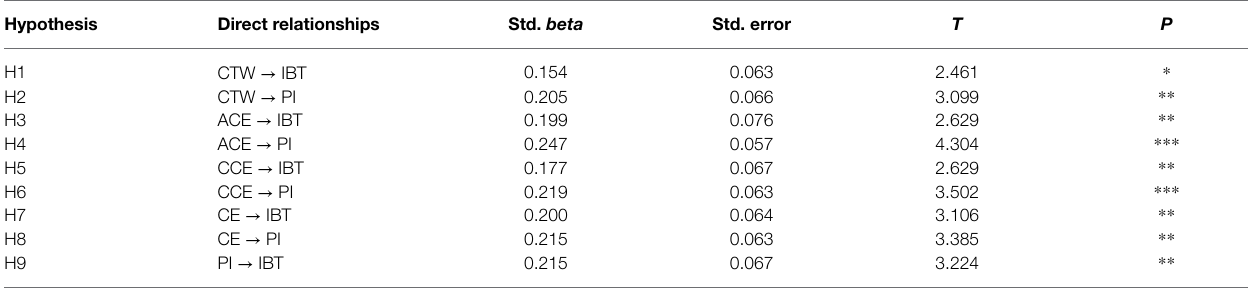
TABLE 4 | Hypotheses testing direct